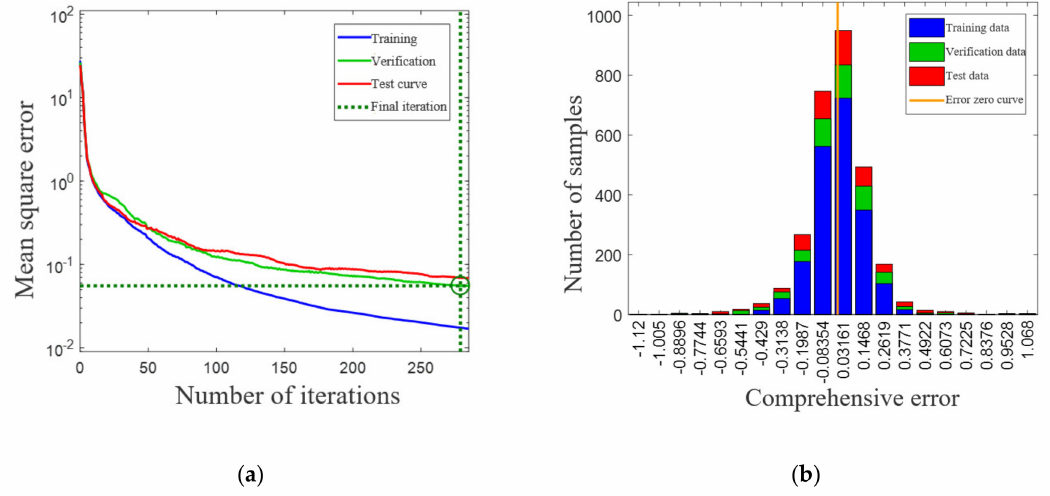
Figure 8. Performance of a multilayer perceptron classifier with 28 hidden layer nodes. ( a ) Mean square error change during training. It can be seen that as the number of iterations increases, the three curves of training data, validation data, and test data have the same downward trend. The optimal value of the mean square error reached the set mean square error after about 280 iterations. ( b ) Comprehensive error distribution of the classifier. It can be seen that the error distribution of the training data, test data and verification data, the error in the range of -0.429-0.3771 accounts for about